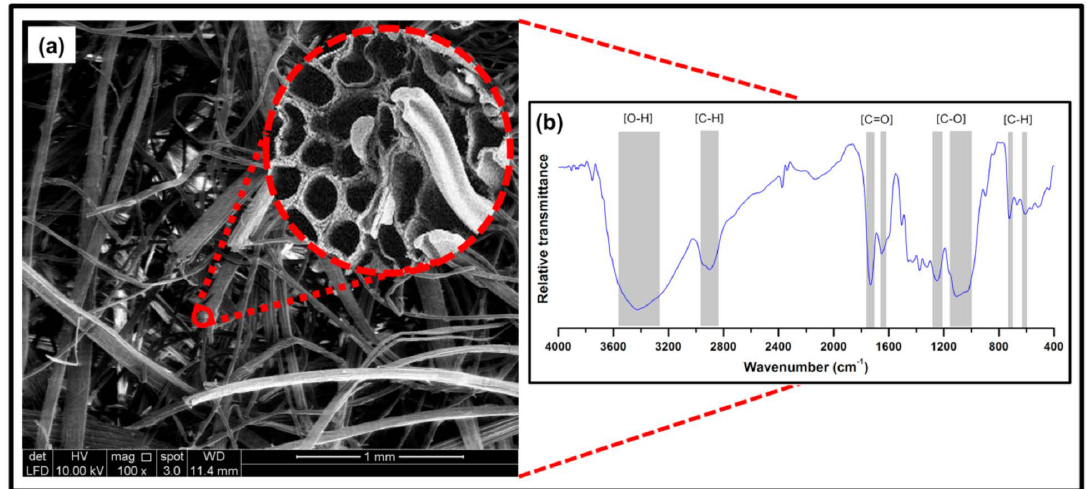
Figure 3. ( a ) FESEM micrograph and cross-section of nonwoven kenaf fibre, and ( b ) FT-IR spectra of nonwoven kenaf